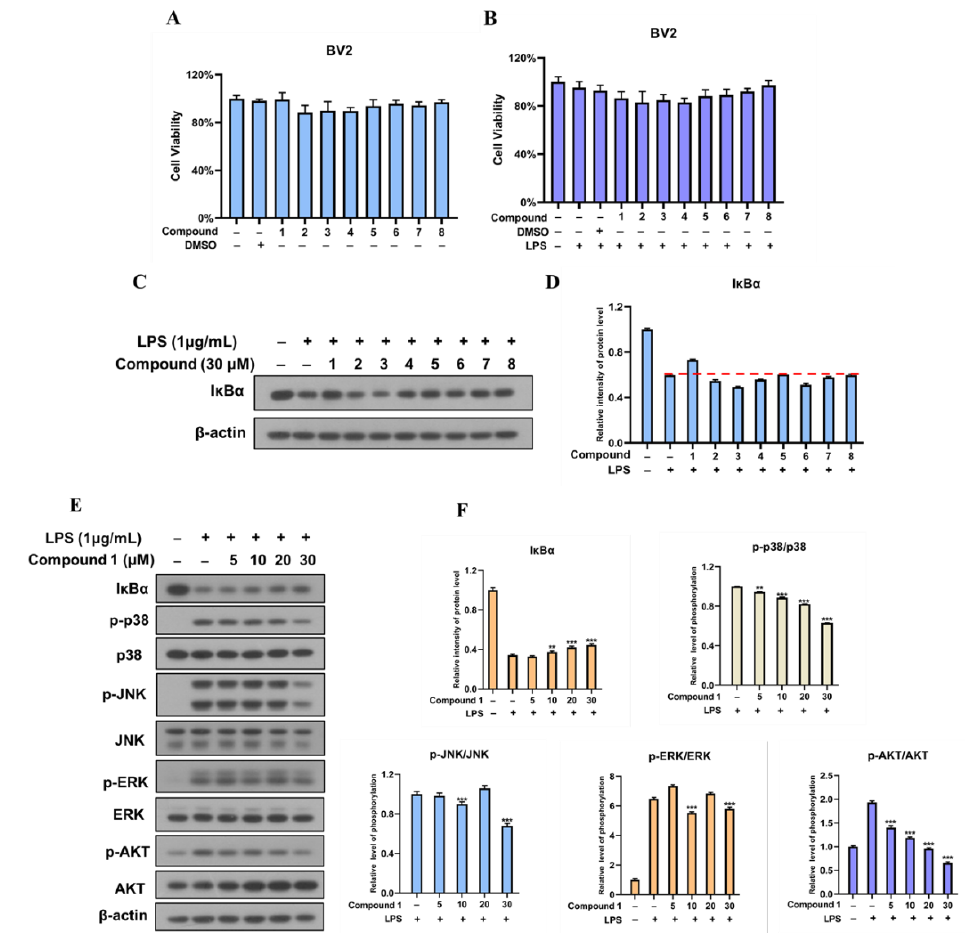
Figure 6. ( A ) BV-2 microglia cells were treated with compounds 1 – 8 (30 μM) or DMSO (0.03%) for 24 h. The viability of cells was measured by MTT assay. ( B ) BV-2 microglia cells were treated with compounds 1 – 8 (30 μM) or DMSO (0.03%) for 24 h. Then, cells were incubated with LPS (1μg/mL) for 30 min. The viability of cells was evaluated by MTT assay. ( C ) BV-2 microglia cells were treated with compounds 1 –8 (30 μM) for 24 h. After exposed to LPS (1μg/mL), cells were harvested and the